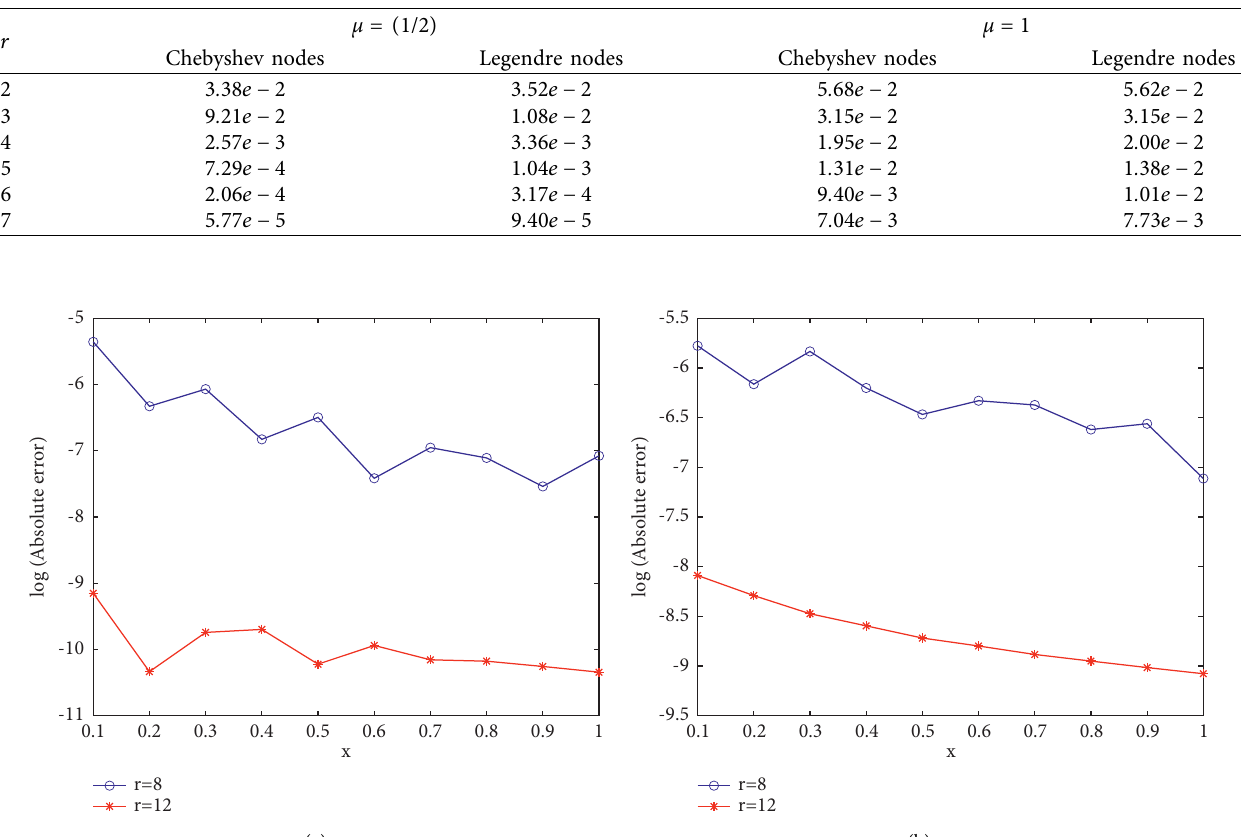
Table 3: The L 2 -errors at the Legendre and Chebyshev nodes taking different μ for Example 2.